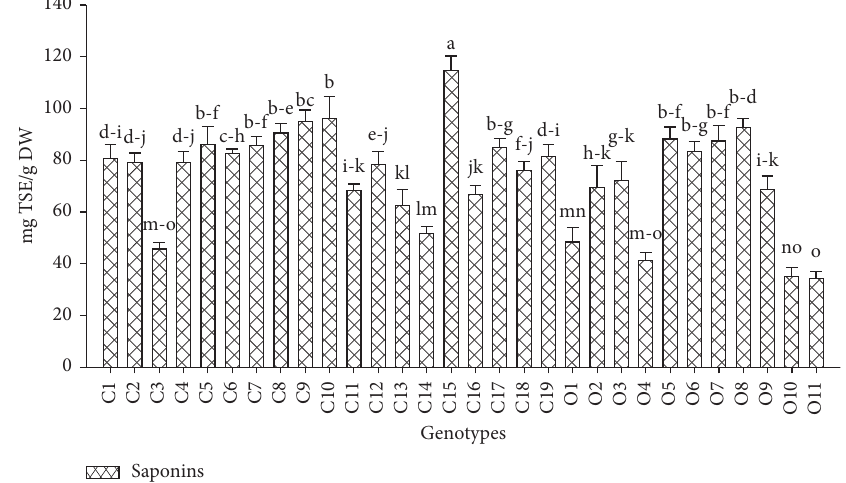
Figure 4: Variation in the content of total saponins. Table 2: Mineral content of different genotypes of C. capsularis and C. olitorius